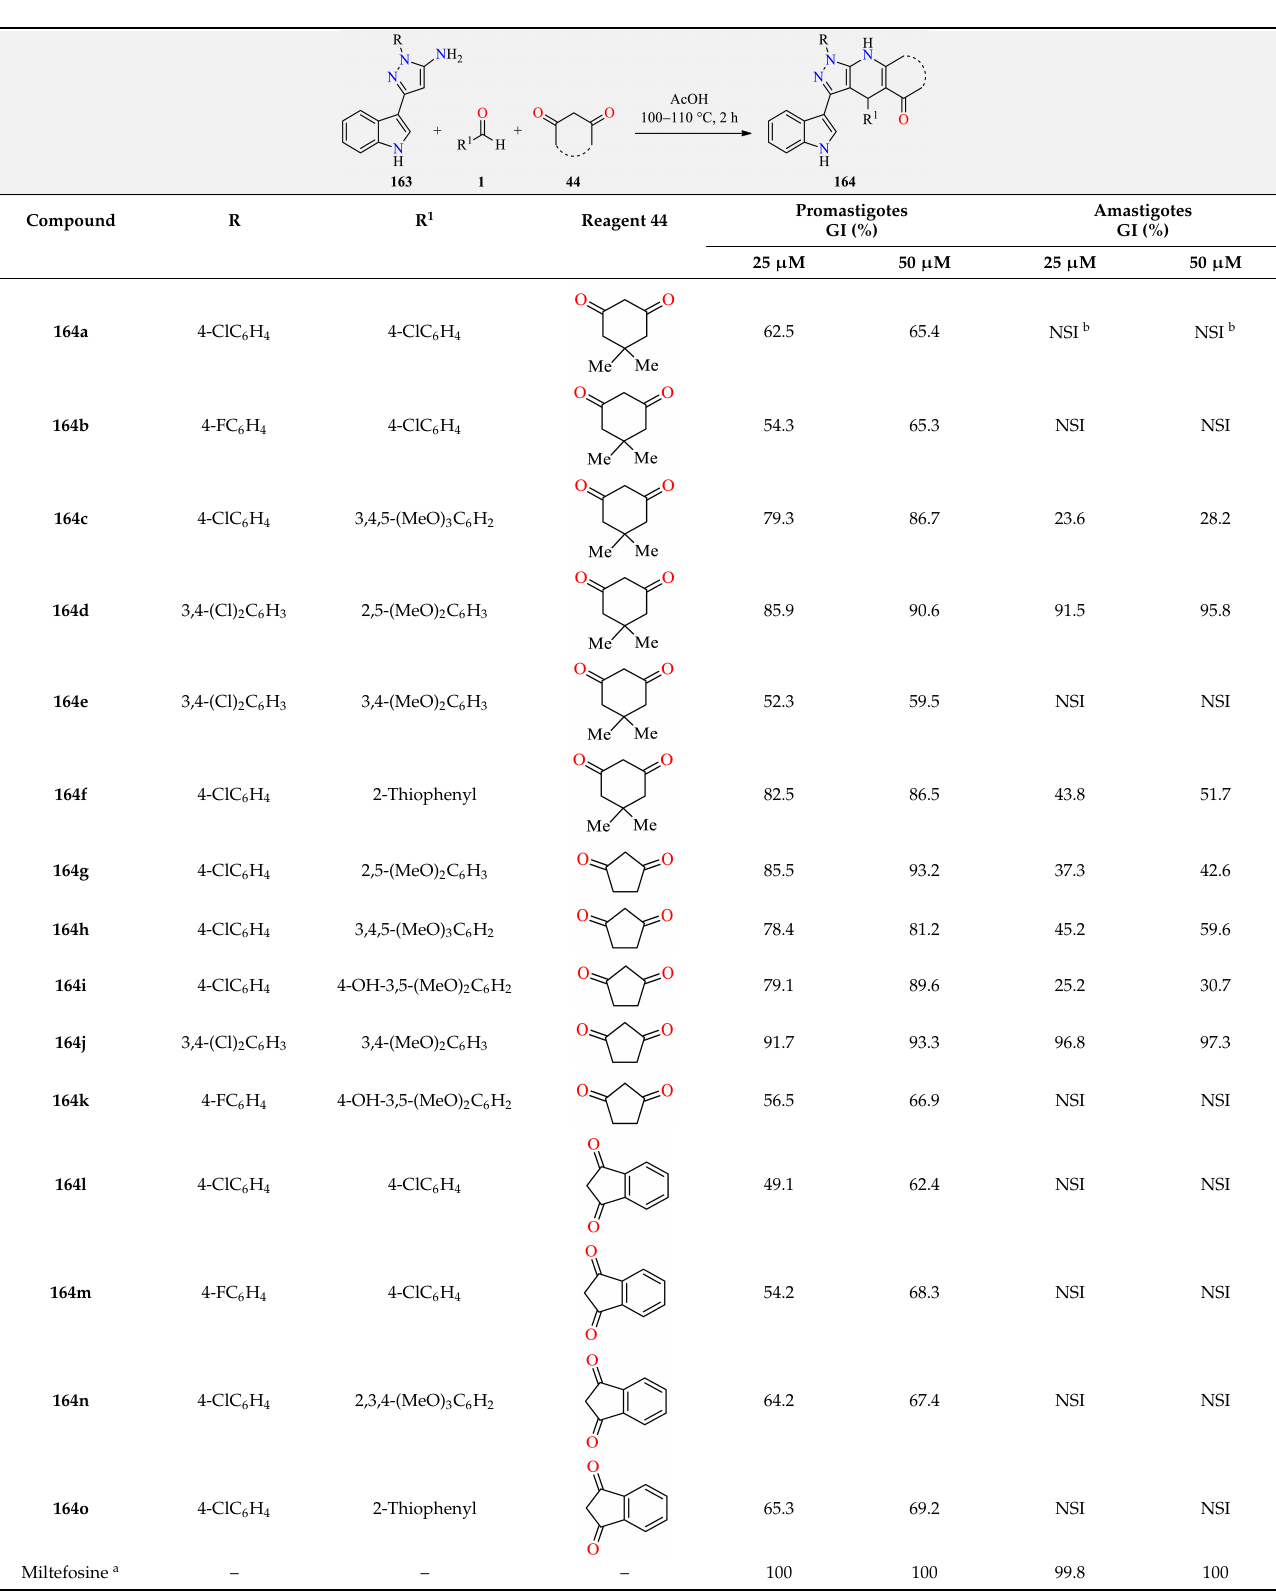
Table 54. Three-component synthesis and in vitro antileishmanial activity of pyrazolodihydropy- ridines 164